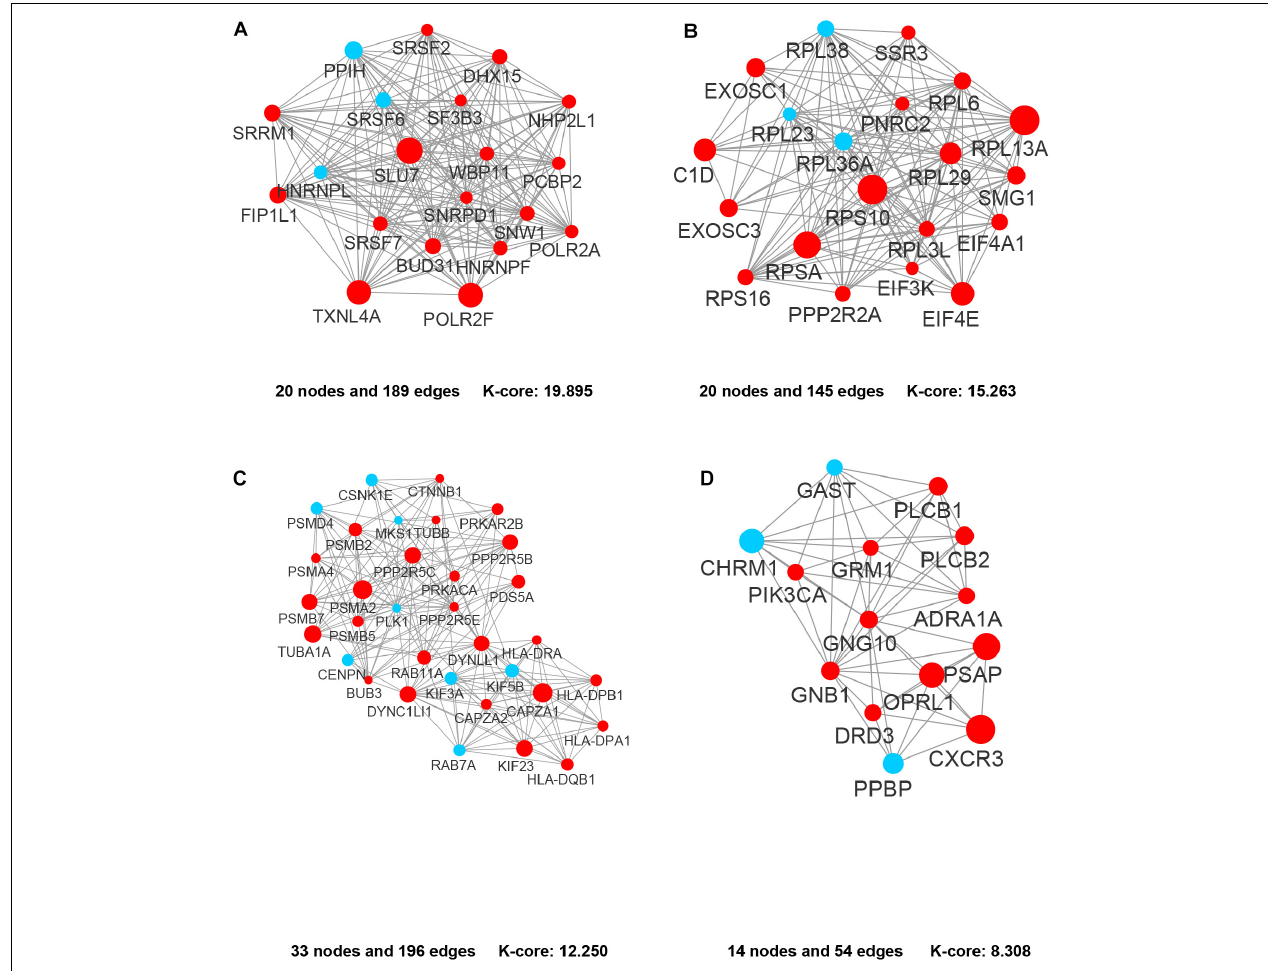
FIGURE 9 | The clusters of the genes co-expressed with ACE2. (A) Cluster 1. (B) Cluster 2. (C) Cluster 3. (D) Cluster 4. The nodes representing positively correlated genes are shown as red circles and the negatively correlated genes are presented as blue circles. The sizes of the nodes are illustrated from small to big in ascending order of r